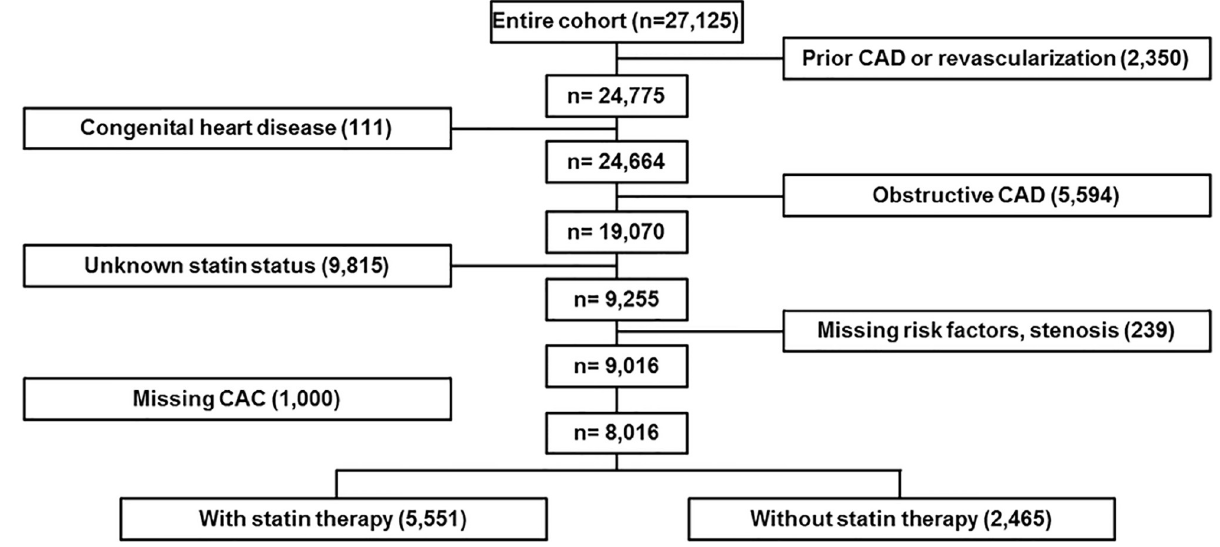
Fig 1. Flow diagram for patient enrollment. A total of 8,016 patients met the inclusion criteria.